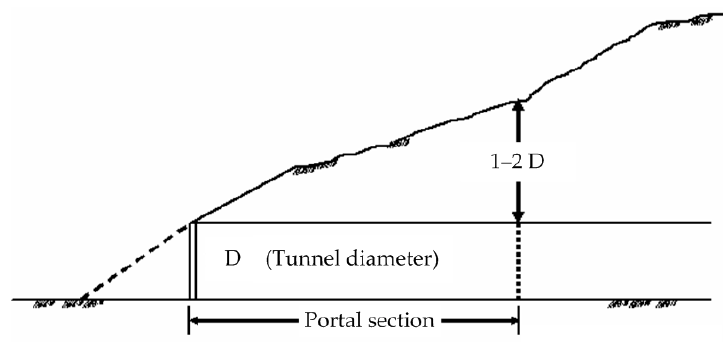
Figure 1. Schematic diagram for standard portal section ranges. The portal section varies depending on the geological conditions.